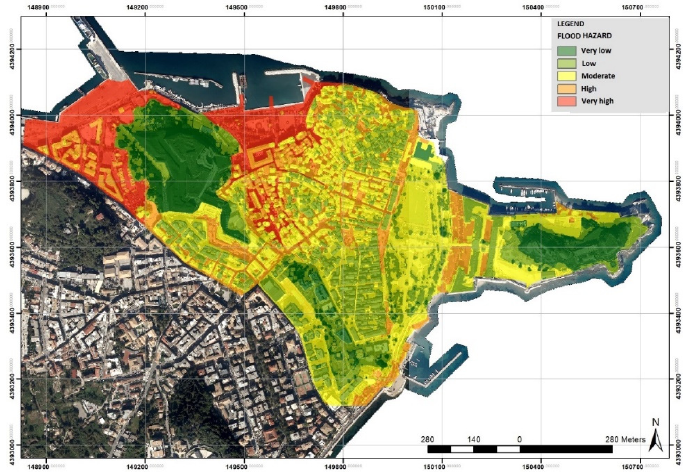
Figure 16. Flood hazard map for the average rain rate of the reference period (1971–2004) .